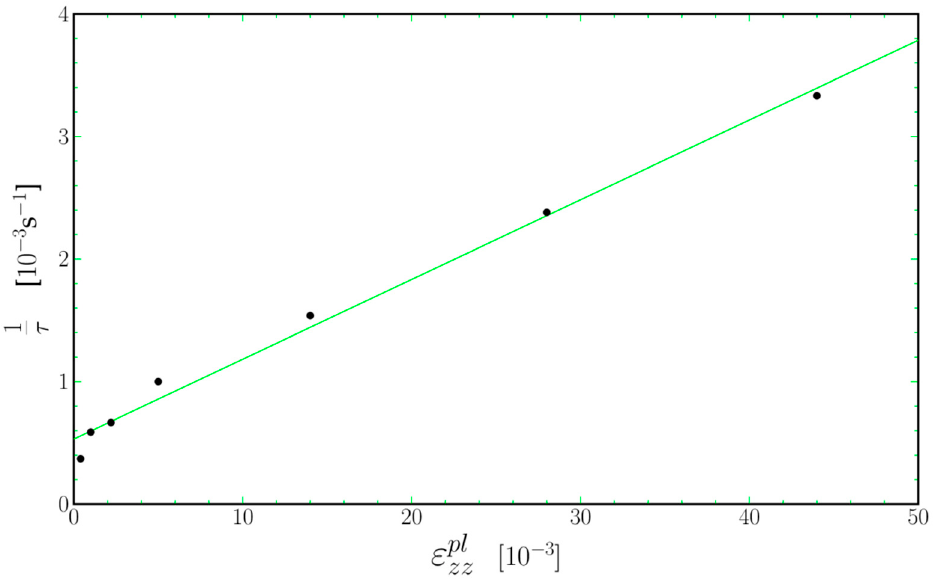
Figure 12. Variation of the relaxation time τ as function of the plastic deformation ε pl zz of the γ phase during a creep test of “ standard ” sample.